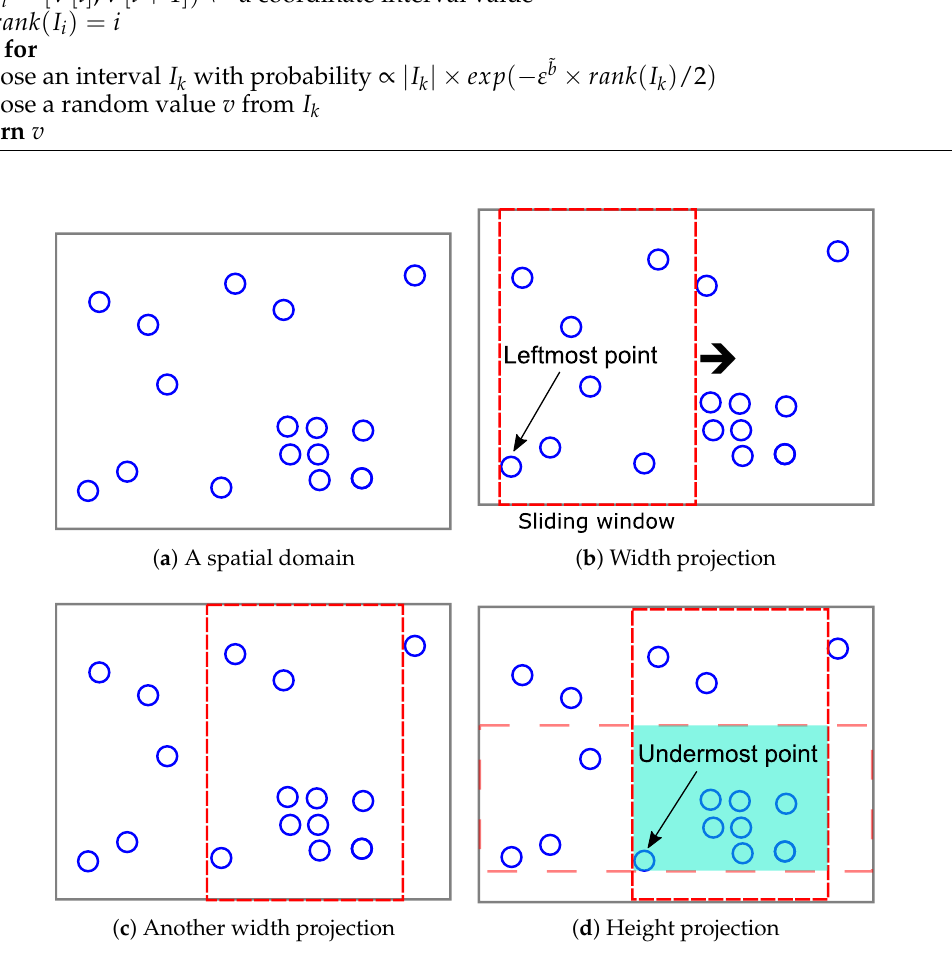
Figure 6. Hotspot detection using the sliding window